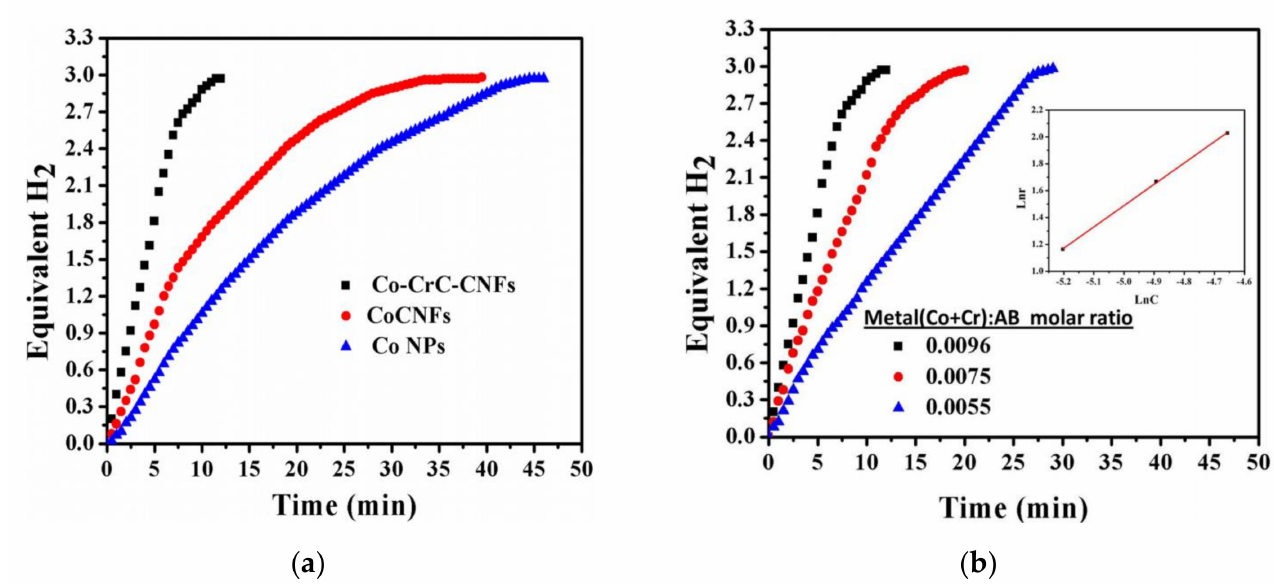
Figure 10. ( a ) Catalytic performance of Co-CrC-NFs, CoC NFs, and Co NPs in hydrolysis AB reaction; ( b ) Effect of metal concentration on H 2 generation. Reprinted from reference [9] with permission from